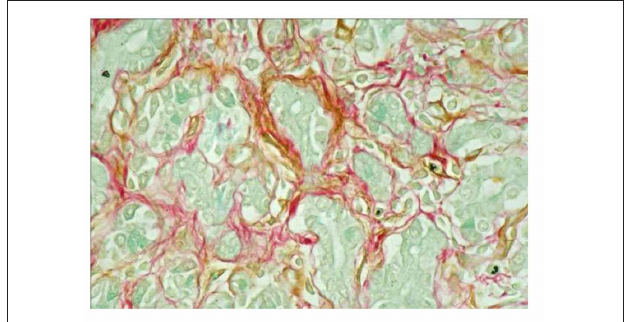
FIGURE 4 | Dual staining of a human chronic pancreatitis section immunostained for the PSC activation marker α smooth muscle actin ( α SMA) and for collagen using Sirius Red. The brown staining for α SMA is co-localized with the red staining for collagen indicating the presence of activated PSCs in fibrotic areas of the pancreas. Reprinted with permission from Elsevier